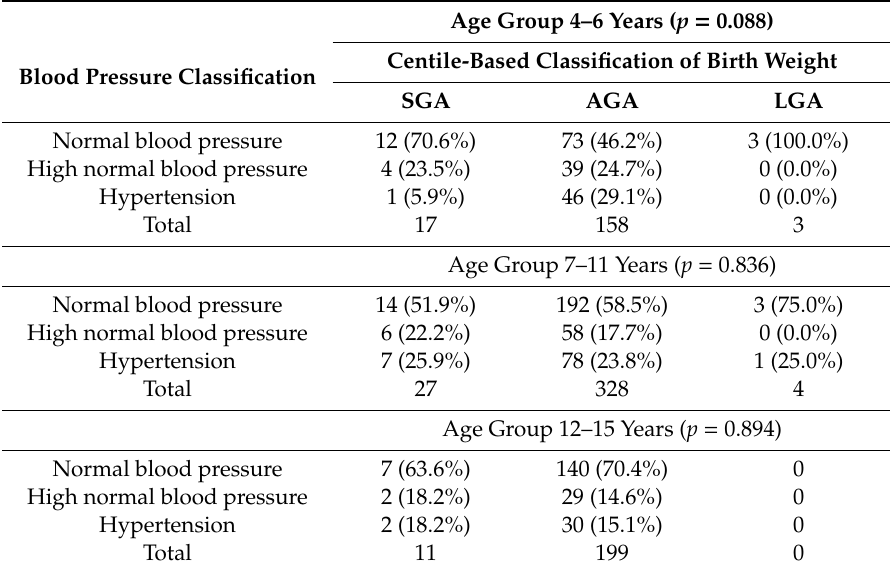
Table 4. Classification of birth weight versus hypertension in the age groups.